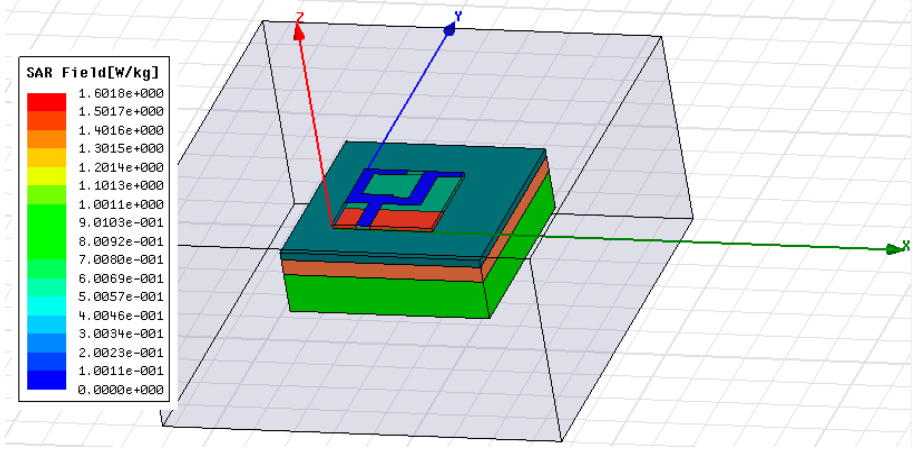
Figure 23. Simulated specific absorption rate (SAR) pattern at 7GHz.